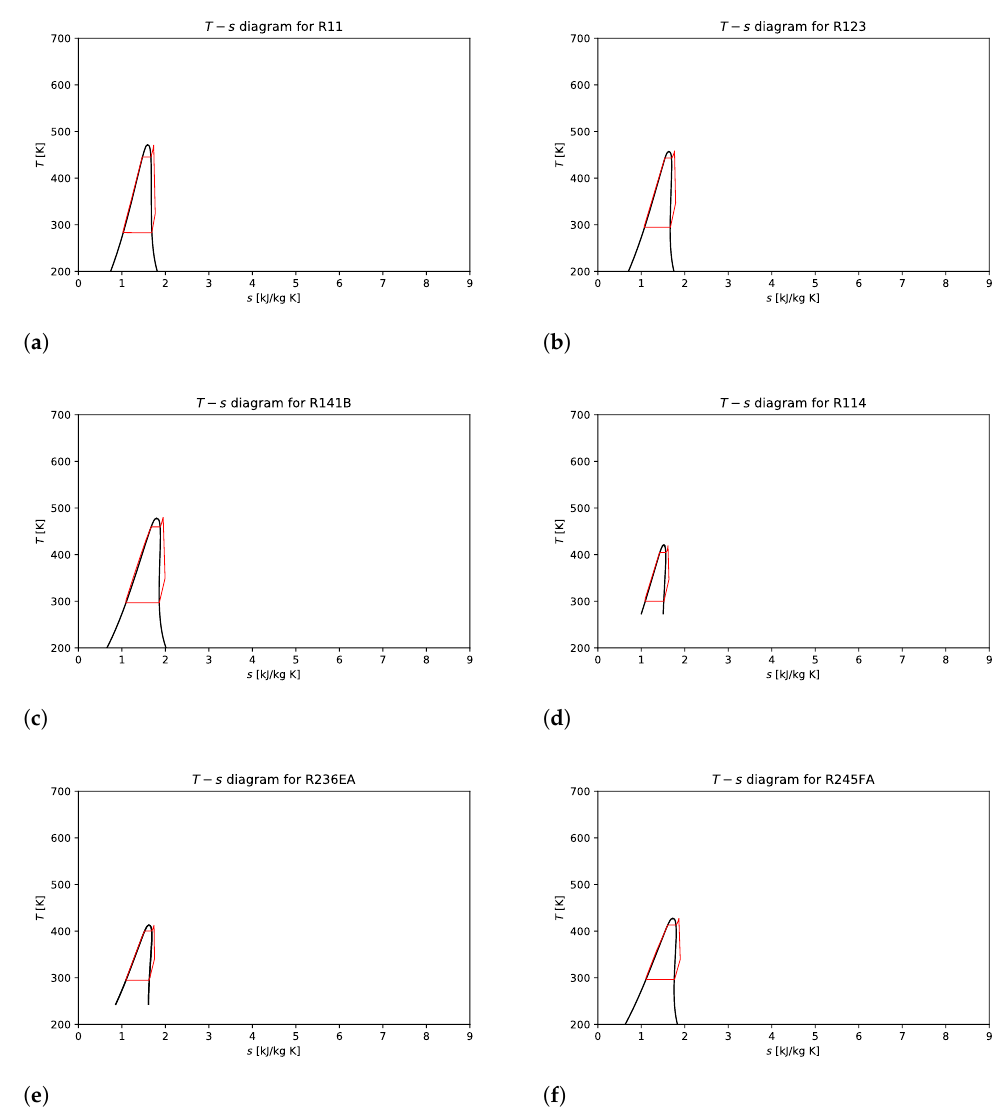
Figure 6. T–s diagrams for fluids of Groups 1 (R11, R123 and R141B) and 2 (R114, R236EA, R245FA).